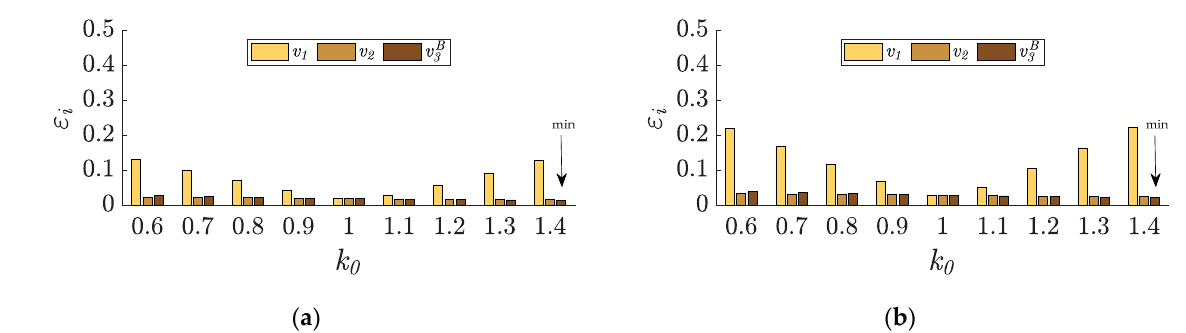
Figure 6. Error index of stator current estimation for ω m = 0.5 ω mN and faulty CS in phase B : ( a ) t L = 0.25 t LN ; ( b ) t L = 0.75 t LN .